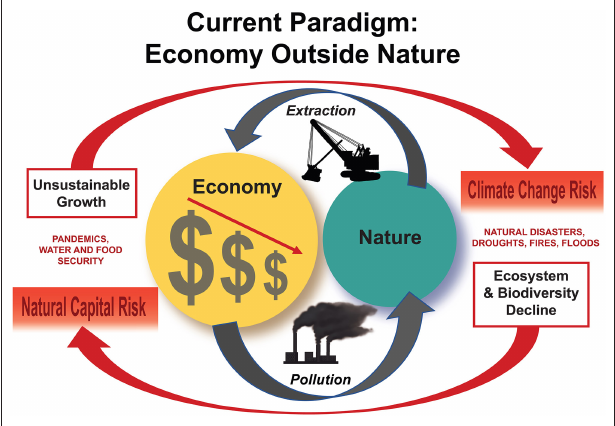
FIGURE 1 | Current paradigm: economy outside